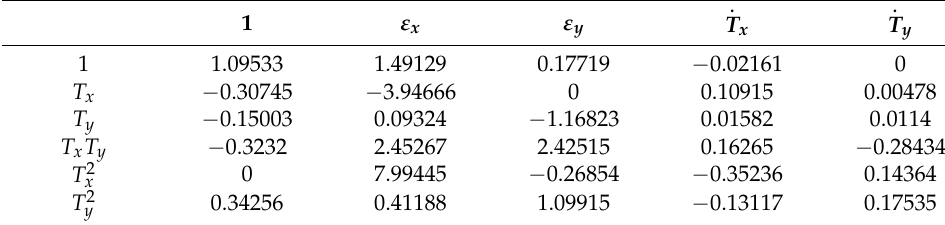
Table 3. Fitting results for (cid:101) K tx , tx .